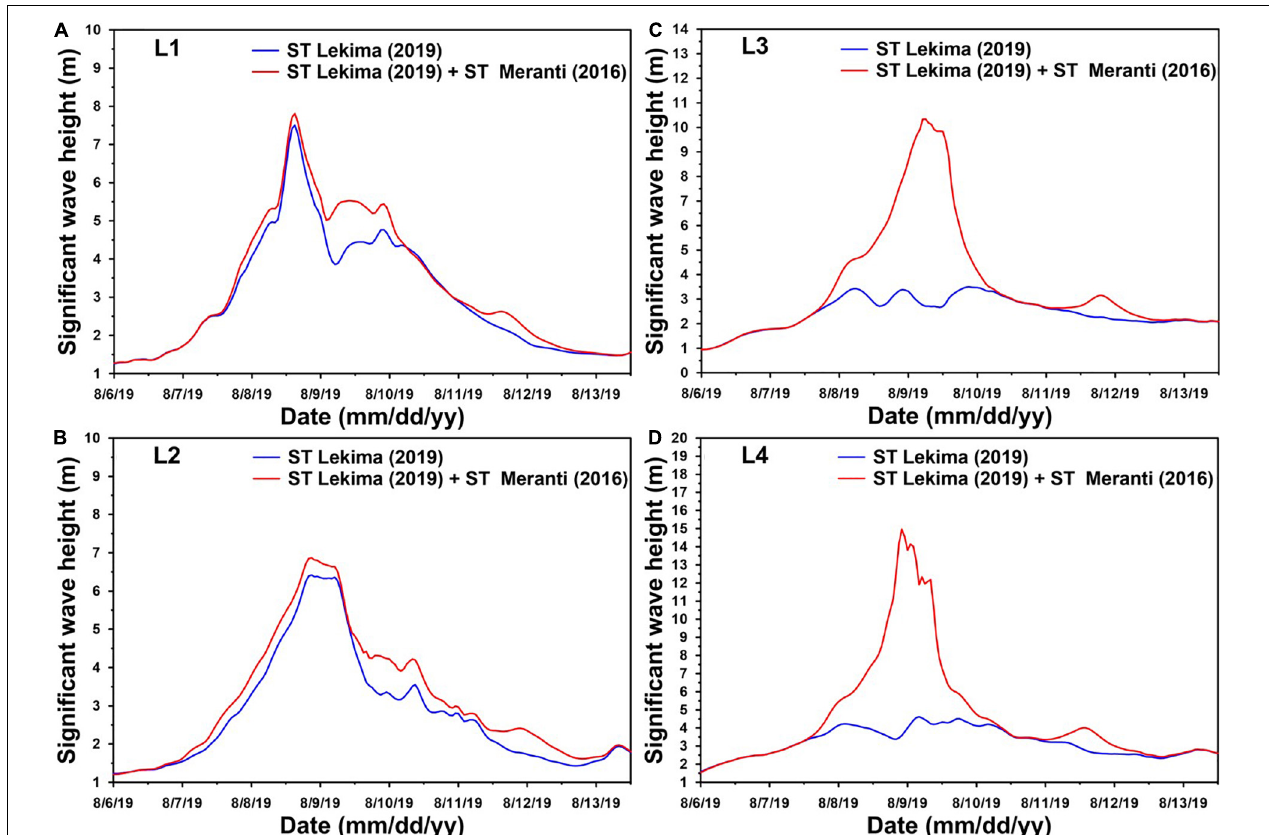
FIGURE 9 | Comparison of significant wave height time series generated by Super Typhoon Lekima in 2019 and designed binary typhoons Lekima (2019) and Meranti (2016) at (A) L1, (B) L2, (C) L3, and (D) L4 four selected representative points.